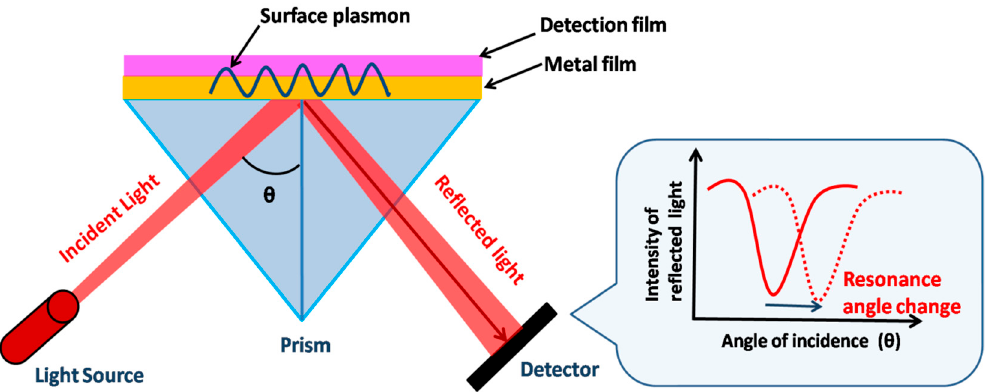
Figure 6. Schematic of SPR-based detection of biomolecules using Kretschmann configuration. The dip in the resonance peak shifts due to the change in the refractive index.